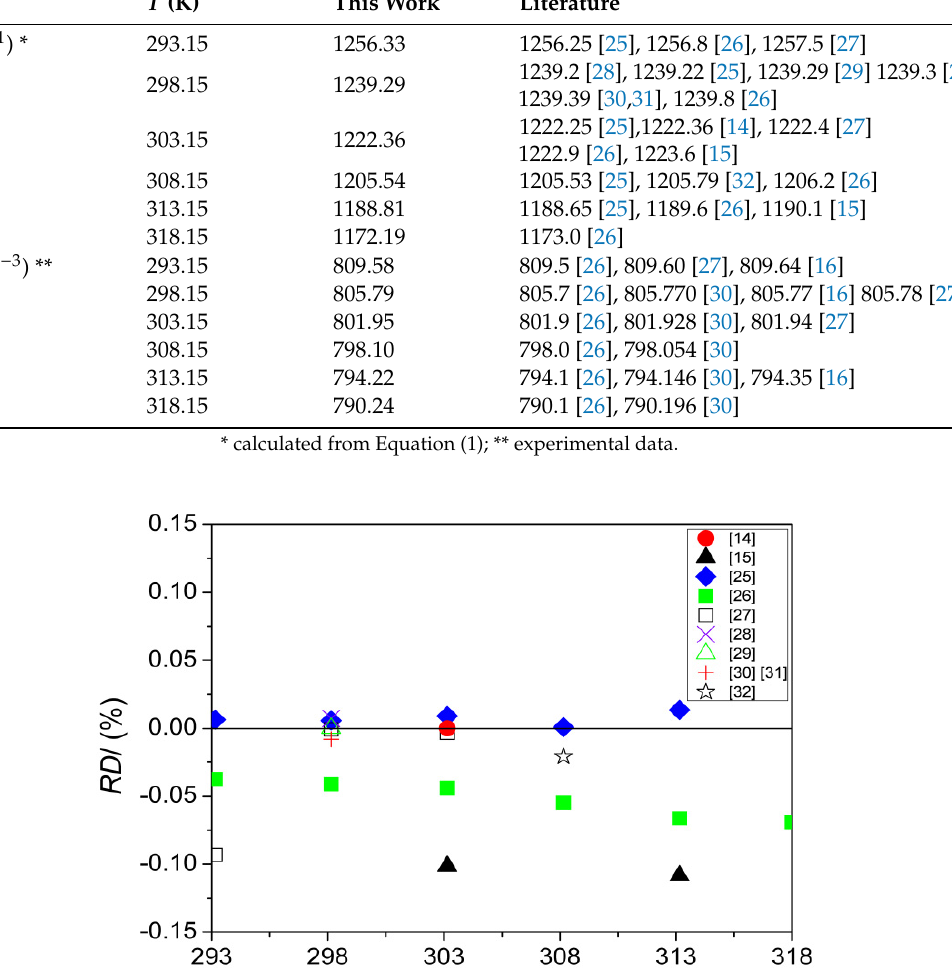
Table 1. Comparison of the speed of sound, u , and density, ρ , at atmospheric pressure obtained in this work with those reported in the literature.